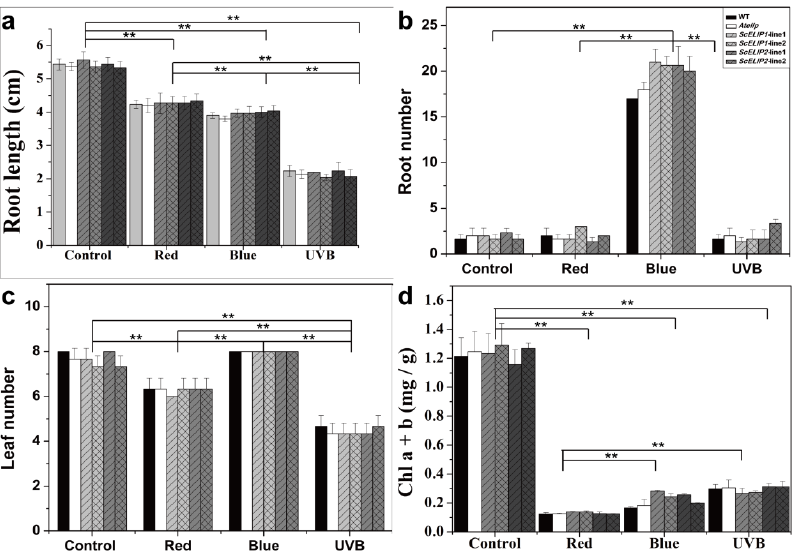
Figure 4. Morphological responses of Col-0 WT, Atelip mutant, and 35S-ScELIP transgenic seedlings to di ff erent light regimes. Panel ( a ), root length in centimeter (cm); panel ( b ), root number; panel ( c ), leaf number; panel ( d ), Total chlorophyll content in milligram (mg) per gram fresh weight. Error bars represent the SD of three biological repeats. ** p < 0.01, P-values were obtained from Dunnett’s T3 test comparing the 35-SScELIP lines with Atelip mutant. P -values also were obtained from Dunnett’s T3 test comparing the control (normal light condition), red, blue, and UVB light with each other. Asterisk represents statistically significant di ff erence within one group or among specific groups delineated by the